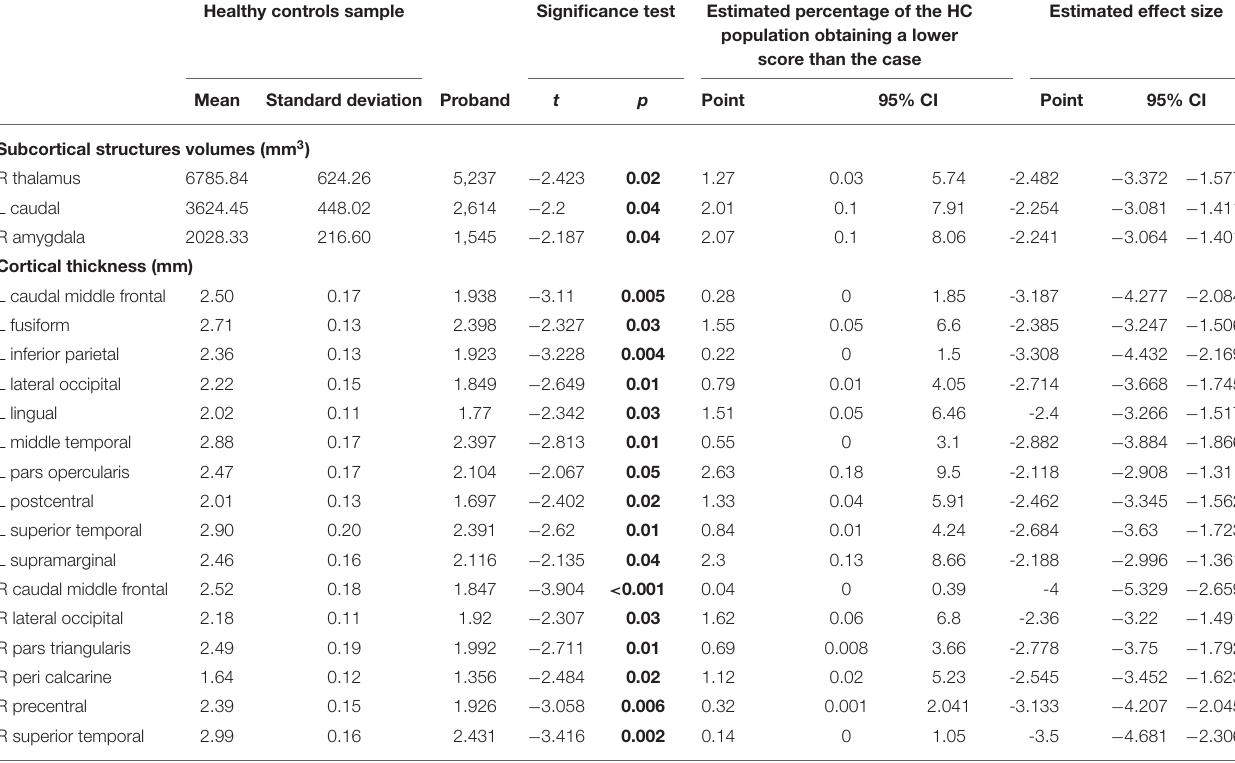
TABLE 2 | Significant difference in subcortical volumes and cortical thickness in proband compared to healthy